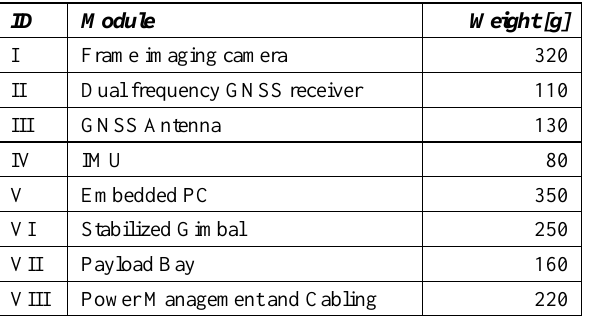
Table 1: Components of MACS-Micro